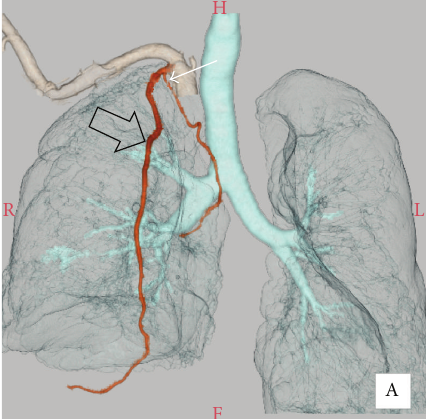
Figure 1: Volume rendering reconstructed image of computed tomography angiography shows a hypertrophic, aberrant right bronchial artery (white arrow) arising from the proximal portion of the right internal mammary artery (black arrow).